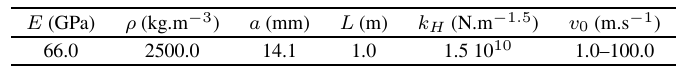
Table 1 beam and Hertz spring